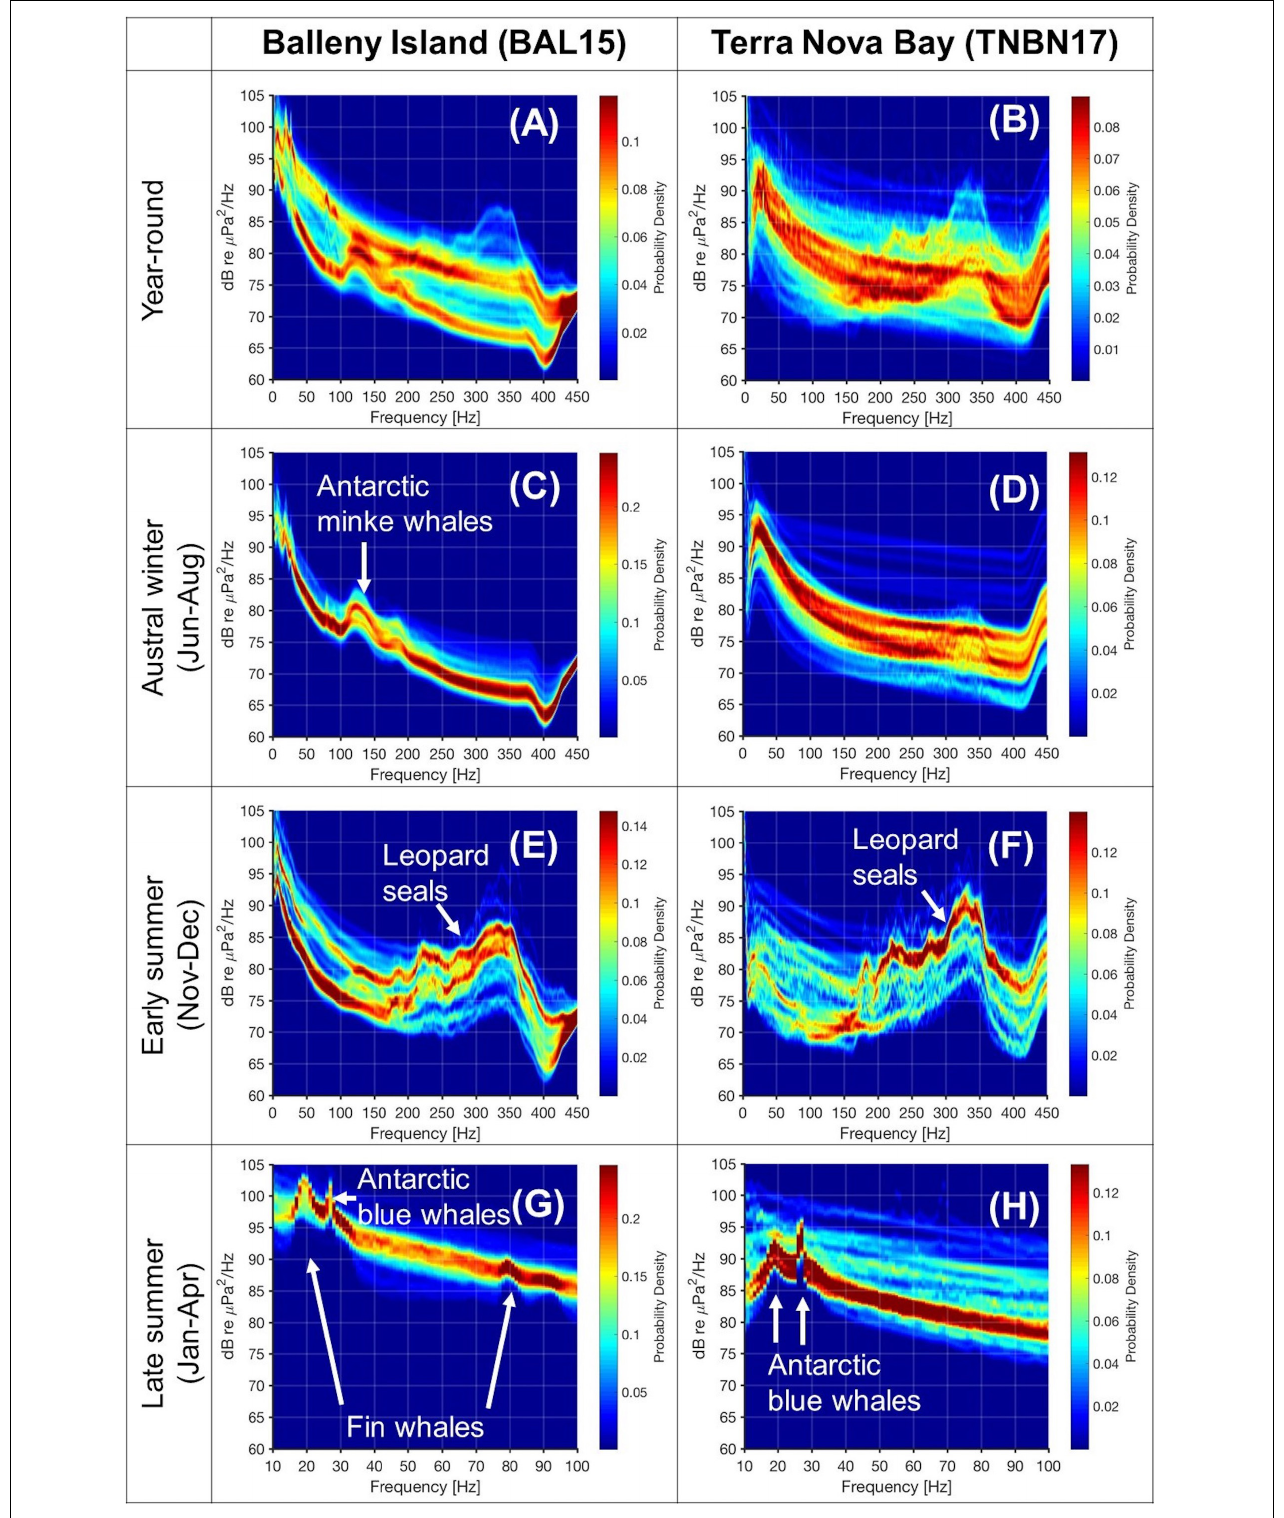
FIGURE 3 | Spectral probability density plots for 1-year records of (A) BAL15 and (B) TNBN17; for austral winter season of (C) BAL15 and (D) TNBN17; for early summer season of (E) BAL15 and (F) TNBN17; and for late summer season of (G) BAL15 and (H) TNBN17.